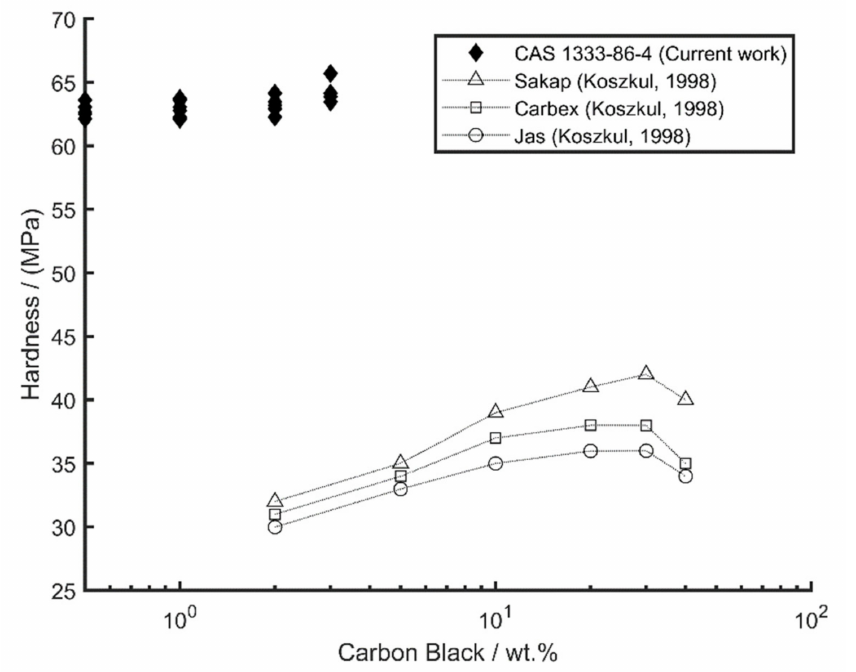
Figure 10. Hardness of iPP with addition of CB. Current data show up to a 3 wt.% of CAS 1333-86-4. Data from the literature showed up to 40 wt.% with trendlines. Different tradenames of CB are provided in